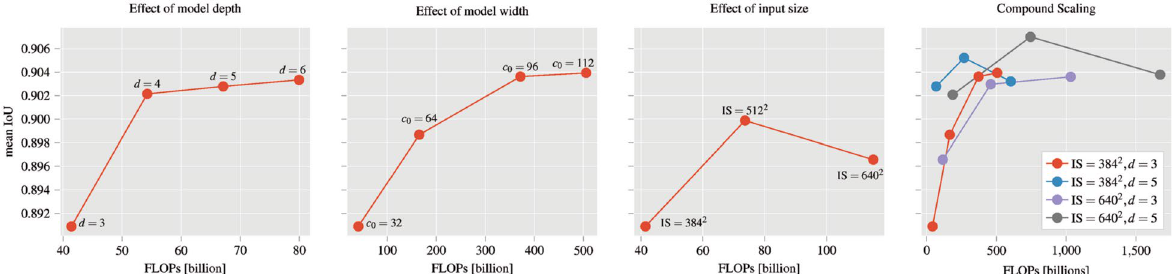
Figure 3. Results for scaling of the U-net. Each plot shows the mean IoU (i.e., averaged over the 4-fold cross validation and the classes) vs the floating point operations per second (FLOPs). For compound scaling, we vary the model width for each step of each run. From left to right: model depth d , model width c o , model input size IS , compound scaling of multiple hyper-parameters.